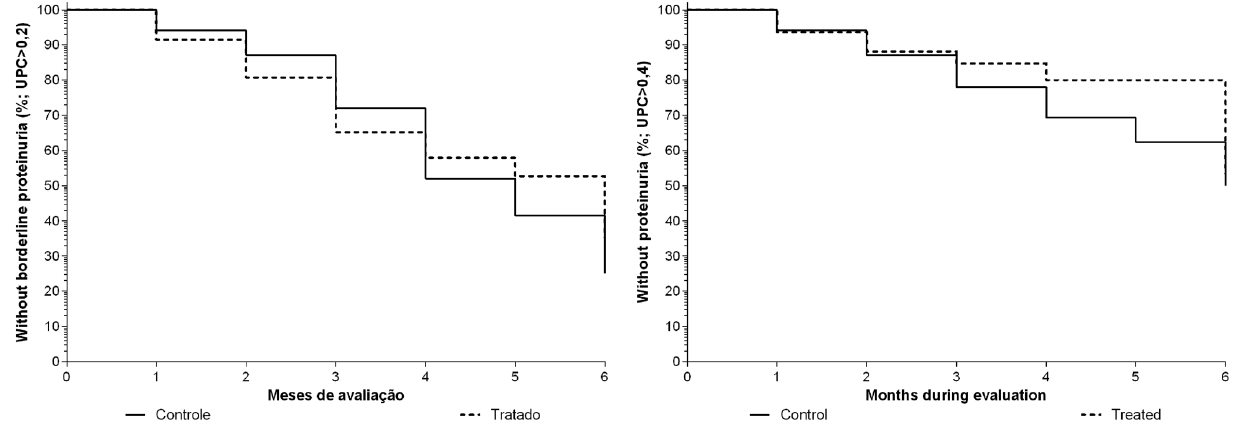
Figure 2. Kaplan Maier survival curves for analysis of borderline proteinuria (left) and true proteinuria (right) in bitches with mammary carcinoma treated (TG) or not treated (CG) with carprofen at 4.4 mg/kg/day for 90 days, during a 6-month follow-up.